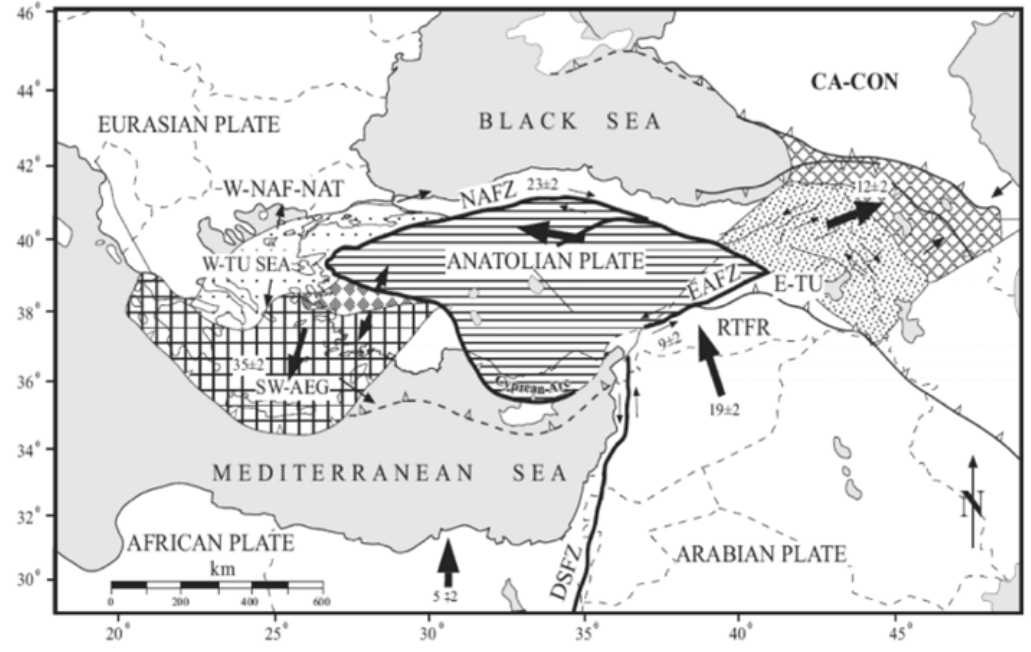
Fig. 1. Tectonic map of Turkey and the surrounding areas. Hatched areas show the coherent motion of specific zones of deformation. Heavy arrows indicate the generalised regional motions in mmyr − 1 (McClusky et al.,